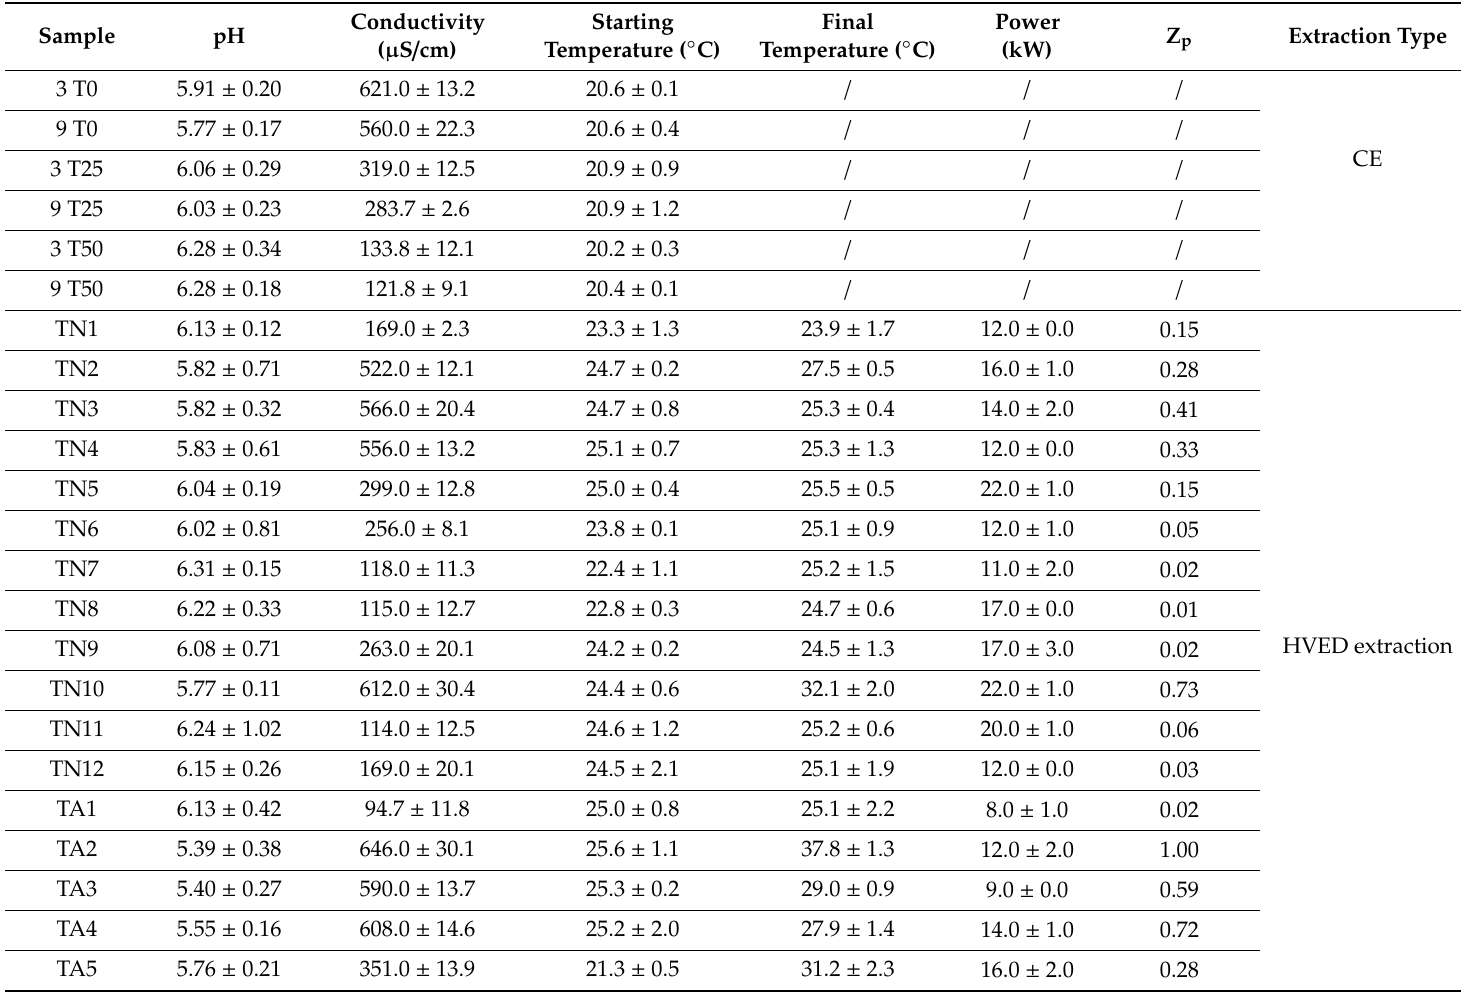
Table 3. Values of pH, conductivity ( µ S / cm) for CE and HVED treated samples, starting temperature ( ◦ C), final temperature ( ◦ C), power (kW) and cell disintegration index after HVED